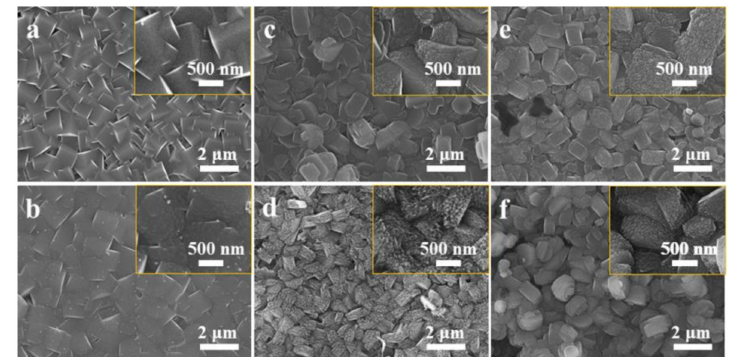
Figure 2. Top-view SEM images of the zeolite membranes. ( a ) ZM-0TP, ( b ) ZM-0.05TP, ( c ) ZM-0.1T, ( d ) ZM-0.15TP, ( e ) ZM-0.1TM, and ( f ) ZM-0.2TM.